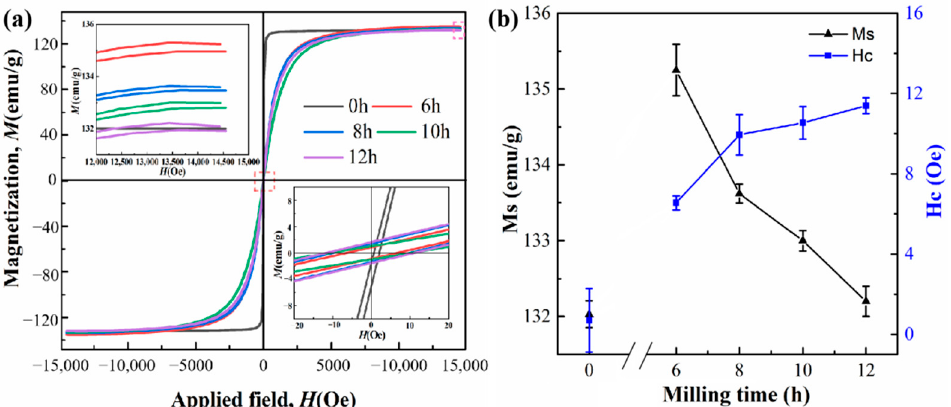
Figure 1. VSM patterns of Fe 73.2 Si 16.2 B 6.6 Nb 3 Cu 1 nanocrystalline alloy: ( a ) hysteresis loops; ( b ) changes in M S and H C as a function of milling time.